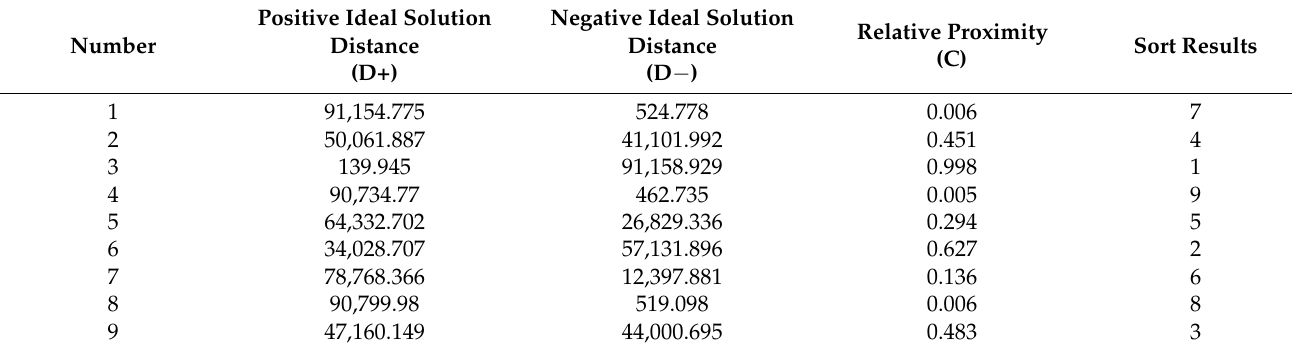
Table 3. TOPSIS evaluation calculation results.